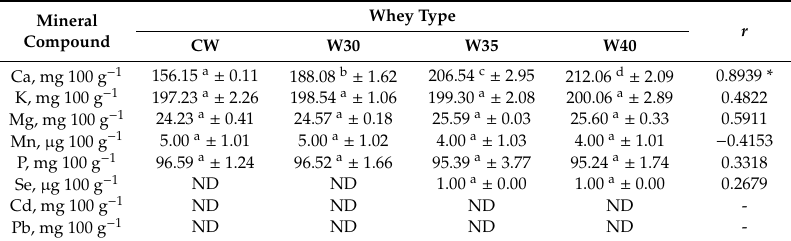
Table 7. Mineral composition of goat